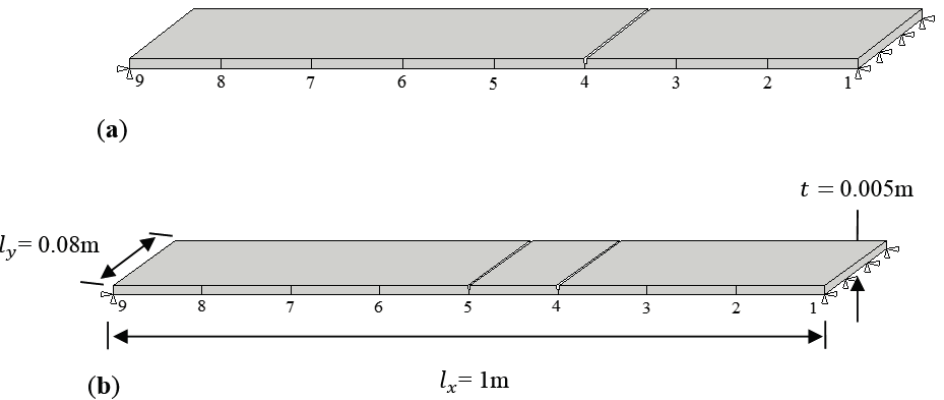
Figure 3. Dimensions and damage locations of plates: ( a ) Case 1; ( b )